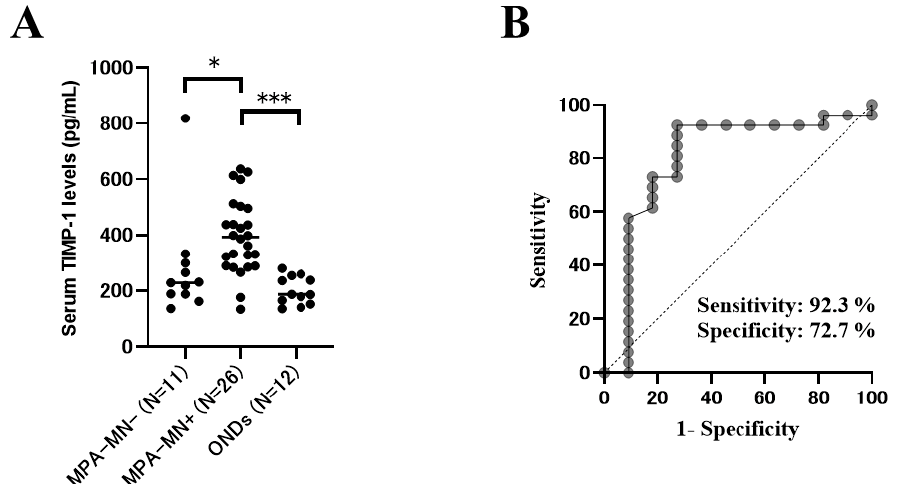
Figure 1. Functions of serum tissue inhibitor of metalloproteinase-1 (TIMP-1) levels as a biomarker for the diagnosis of microscopic polyangiitis (MPA)–motor neuropathy (MN). ( A ) Serum levels of TIMP-1 in the MPA-MN group, MPA without MN group, and other non-inflammatory neurological diseases (ONDs) group. ( B ) Area under the receiving operating characteristic curves for serum TIMP-1 levels to discriminate between MPA-MN and MPA without MN. The Mann–Whitney U test was used for the comparison of median values. A p -value of <0.05 was considered significant. * p < 0.05, *** p < 0.001.